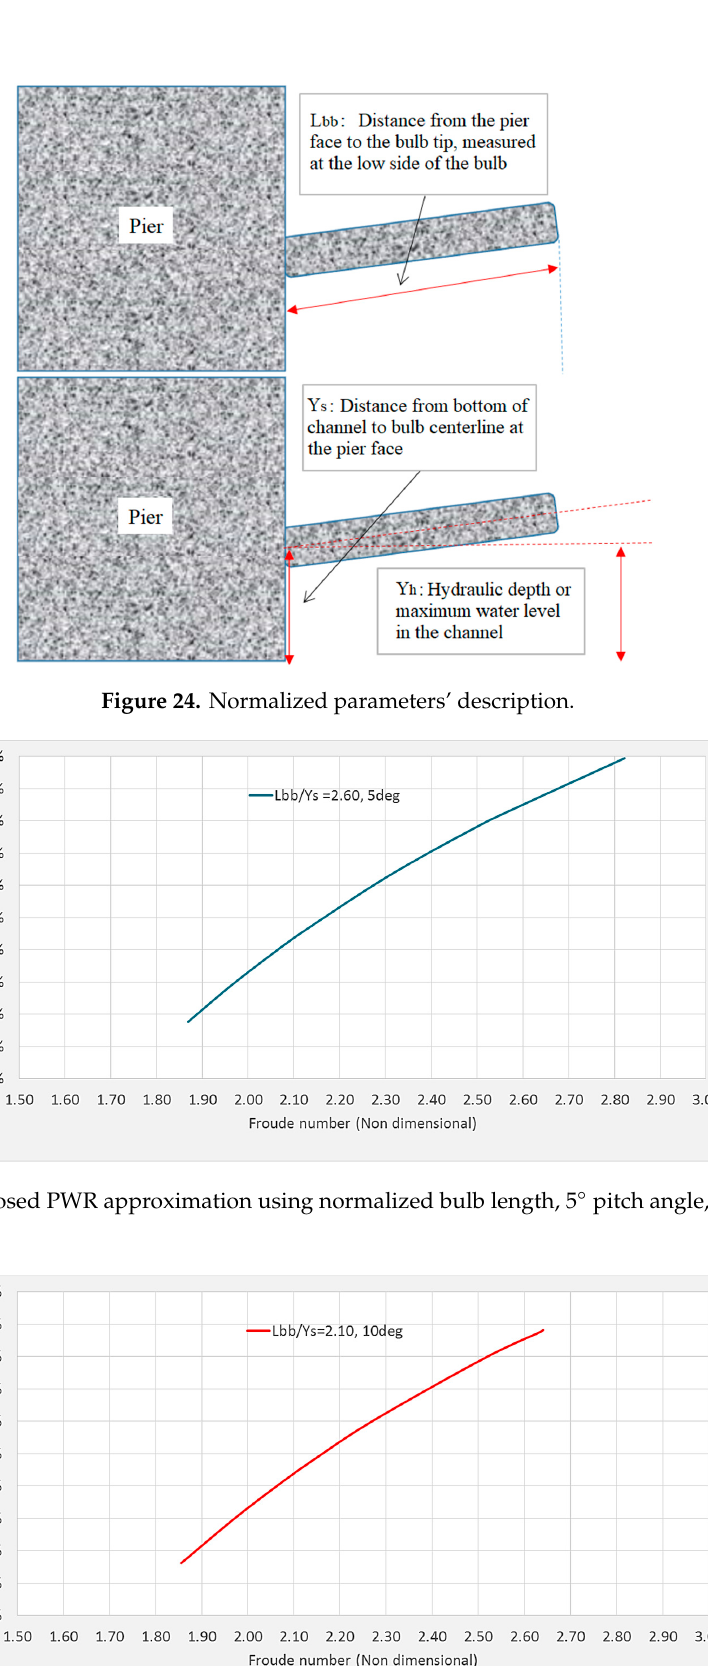
17 of 26 Figure 23. PWR data and PWR calc vs. Froude number (F r ), bulbous pier with 10° pitch angle. 3.7. Design Curves for Pier Wave Reduction The experimental results showed that the bulb’s tip should be above the water level to prevent deck spraying. Consequently, L bb < 0.9 ′ should be ignored. For L bb > 1.2 ′ , an additional bulb length, above the water level, does not contribute to the PWR. Only two bulbs met these restrictions: L bb =